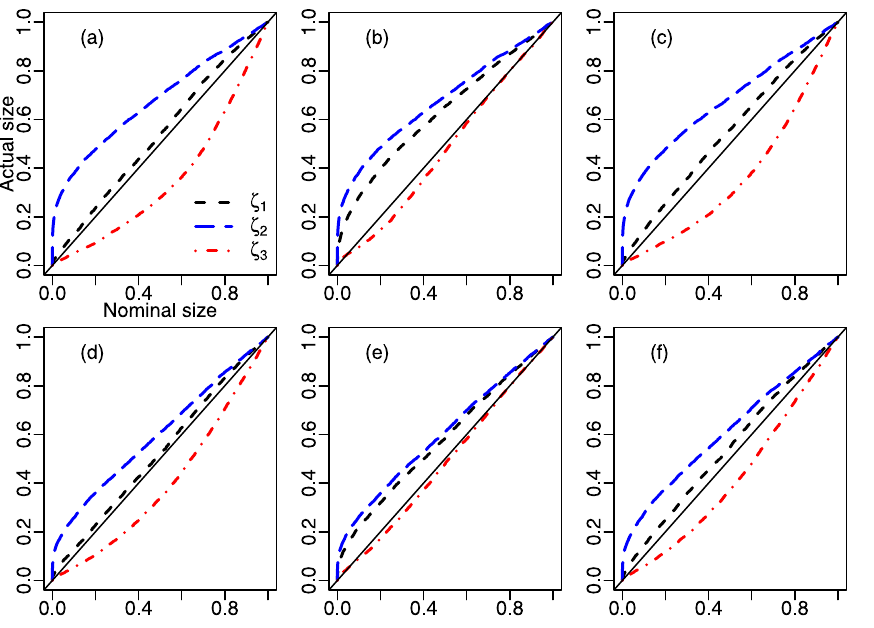
Fig 1. P -value plots; panel (a): B ð 0 : 2 ; 120 Þ and n = 100, panel (b) B ð 0 : 5 ; 120 Þ and n = 100, panel (c) B ð 0 : 75 ; 120 Þ and n = 100, panel (d) B ð 0 : 2 ; 120 Þ and n = 250, panel (e) B ð 0 : 5 ; 120 Þ and n = 250, panel (f) B ð 0 : 75 ; 120 Þ and n =